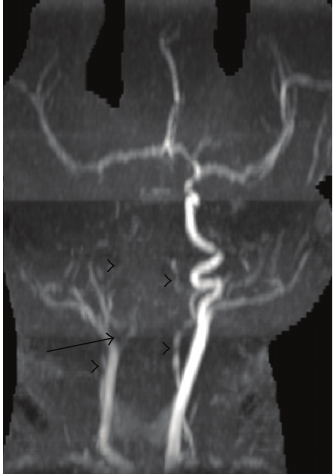
Figure 2: 3D maximum-intensity projection (MIP) image from a 3D time of flight MRA demonstrates occlusion of the right internal carotid artery at its origin (arrow). The vertebral arteries are diminutive (arrowheads) and the basilar artery is not